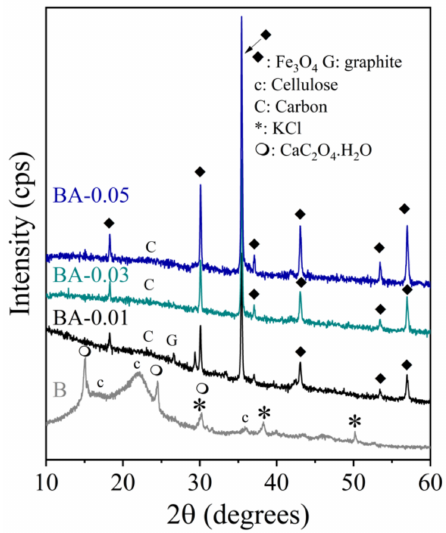
Figure 1. XRD patterns of as-synthesized materials and precursors.